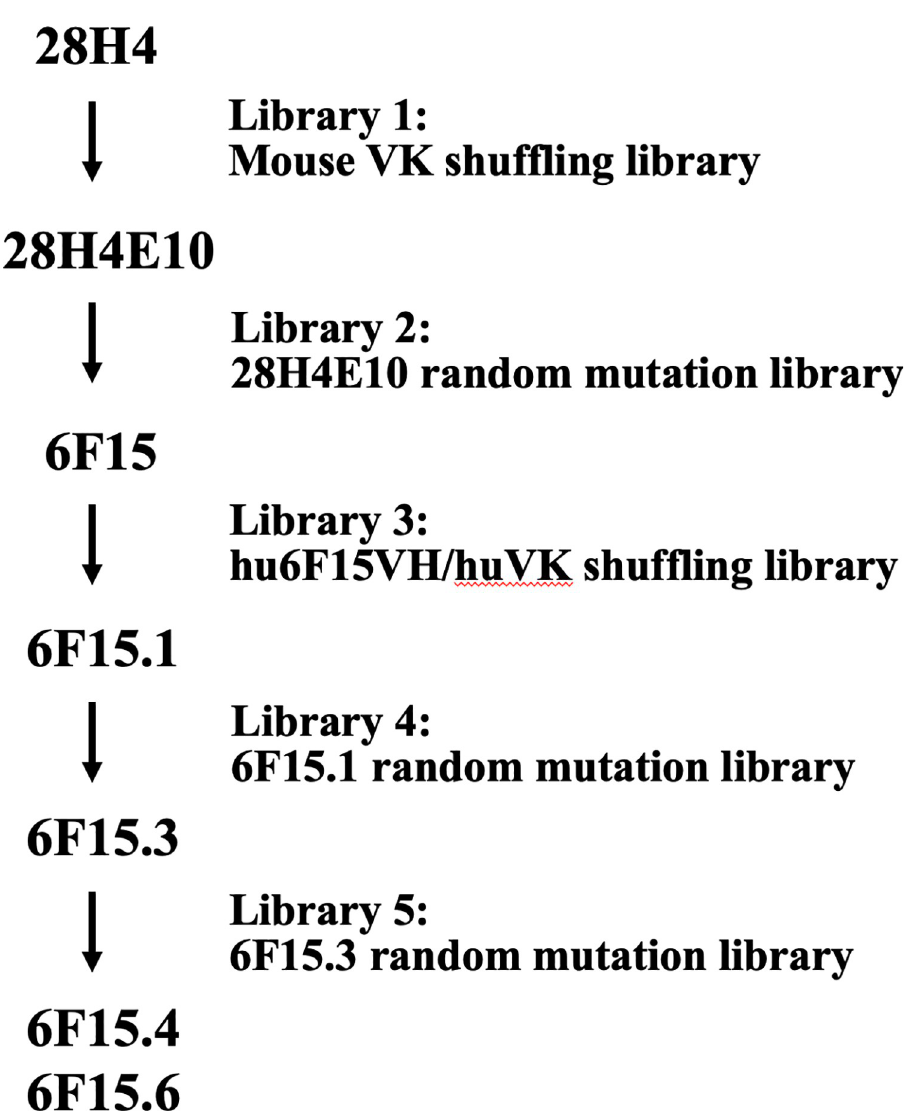
Fig 1. Outline of mAb 28H4 evolution. mAb 28H4 was evolved to mAb hu6F15.4 with four sequential intermediates (28H4E10, 6F15, hu6F15.1, and hu6F15.3) from five designed single-chain variable fragment (scFv) libraries including two light chain shuffling libraries and three random mutation libraries. MAbs hu6F15.4 and hu6F15.6 showed cross- reactivity to seven BoNT/F